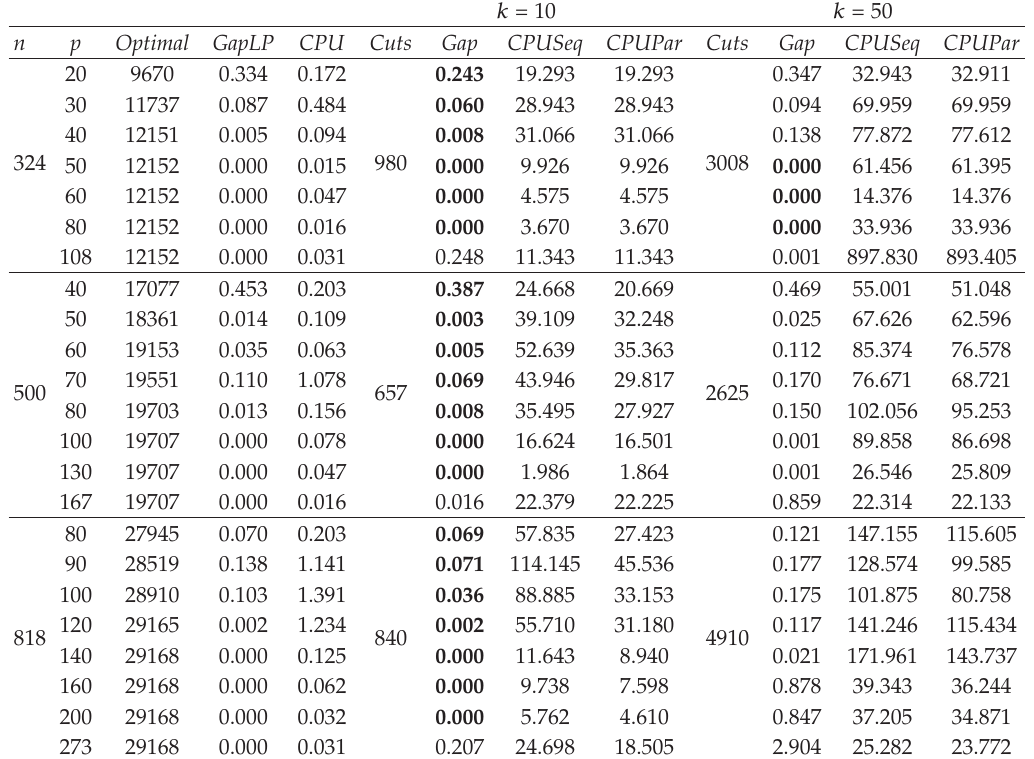
Table 2: Computation times for SJC instances, U (cid:6) 200.